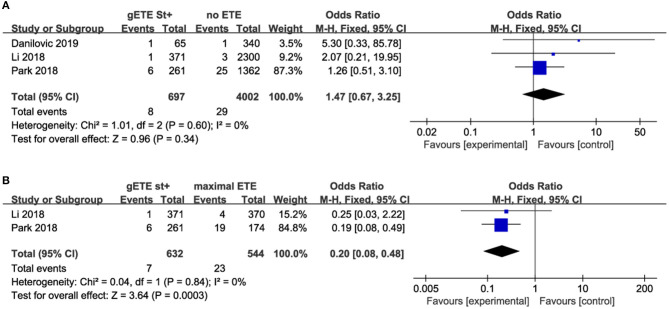
Forest plot for LNM between gETE st+ with (A) no ETE (B) maximal ETE.